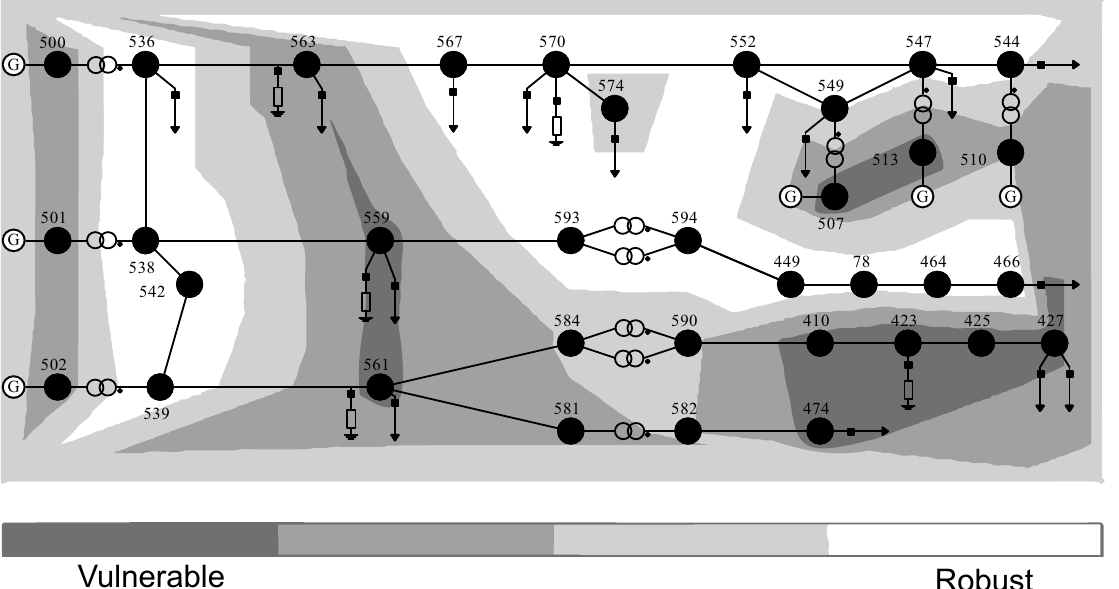
Figure 4. Robustness Areas (RA) map for the São Paulo State power grid during restoration—base case